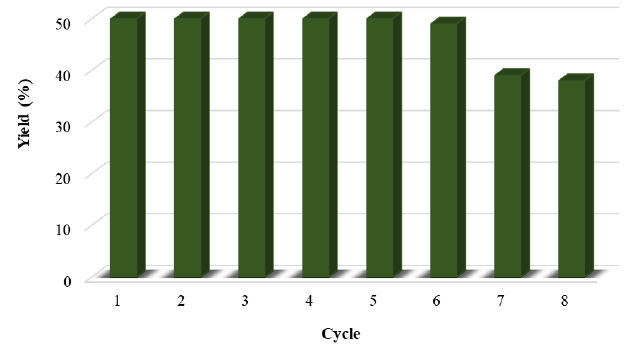
Figure 5. Evaluation of system catalyst and aqueous phase recycle. Reagents and conditions : 0.25 mmol glucose (45 mg), CX4SO 3 H/NbCl 5 (5/7.5 wt%), MW, 150 °C, 17.5 min, water/NaCl, and MIBK (1/3 v / v